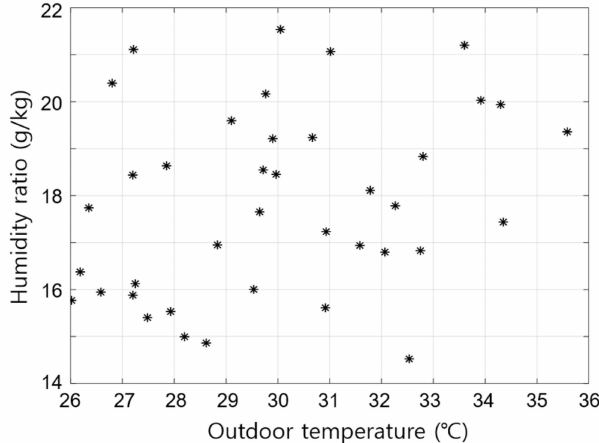
Figure 6. Outdoor conditions considered in the